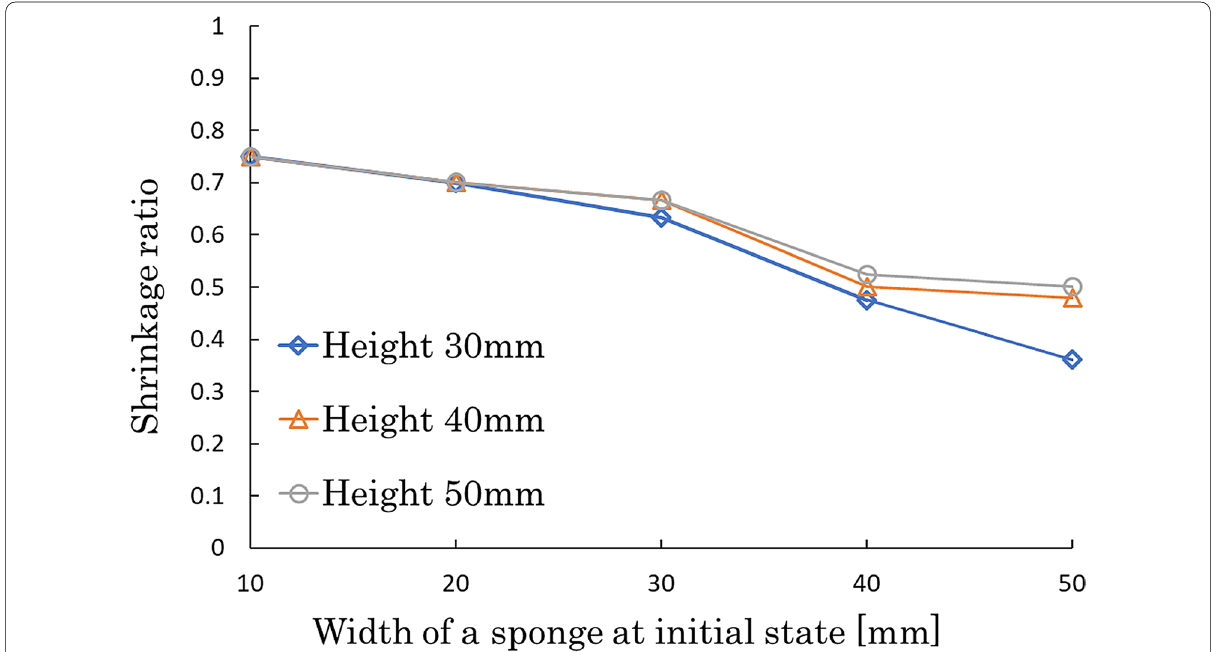
Fig. 3 Relationship between the width of a sponge at the initial state and shrinkage ratio when the inside air pressure of the actuator is The shrinkage ratio was smaller for thinner sponges. The height of the sponges did not affect the shrinkage ratio when the width of the sponge was